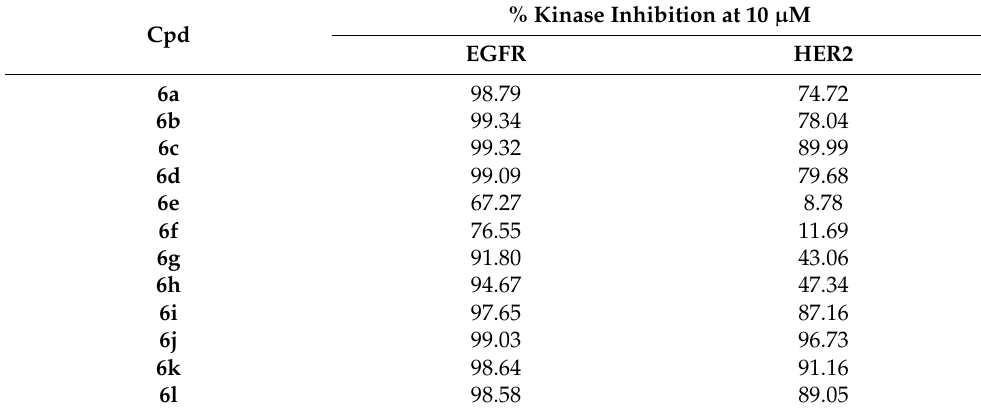
Table 3. % Inhibition values of the synthesized lapatinib derivatives 6a – l over EGFR and HER2 kinases at 10 µ